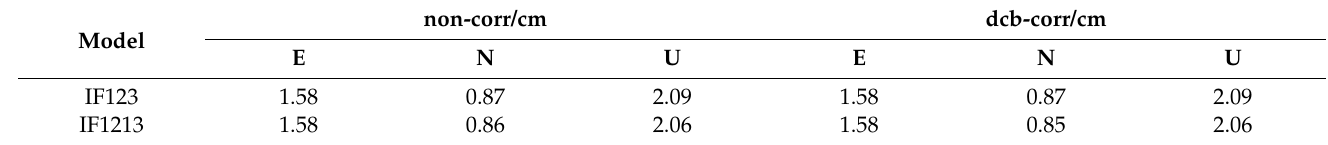
Table 6. Average positioning accuracy of PPP after convergence for IF123 and IF1213 models.